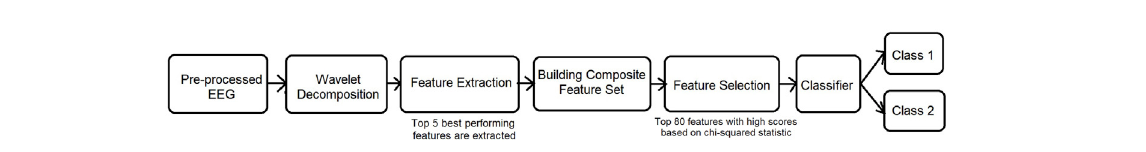
FIGURE 2 Analysis on1DEEGrepresentationwithacompositefeatureset.ThetopperformingfeaturesarefoundtobeHjorthparameters anddifferential entropy.